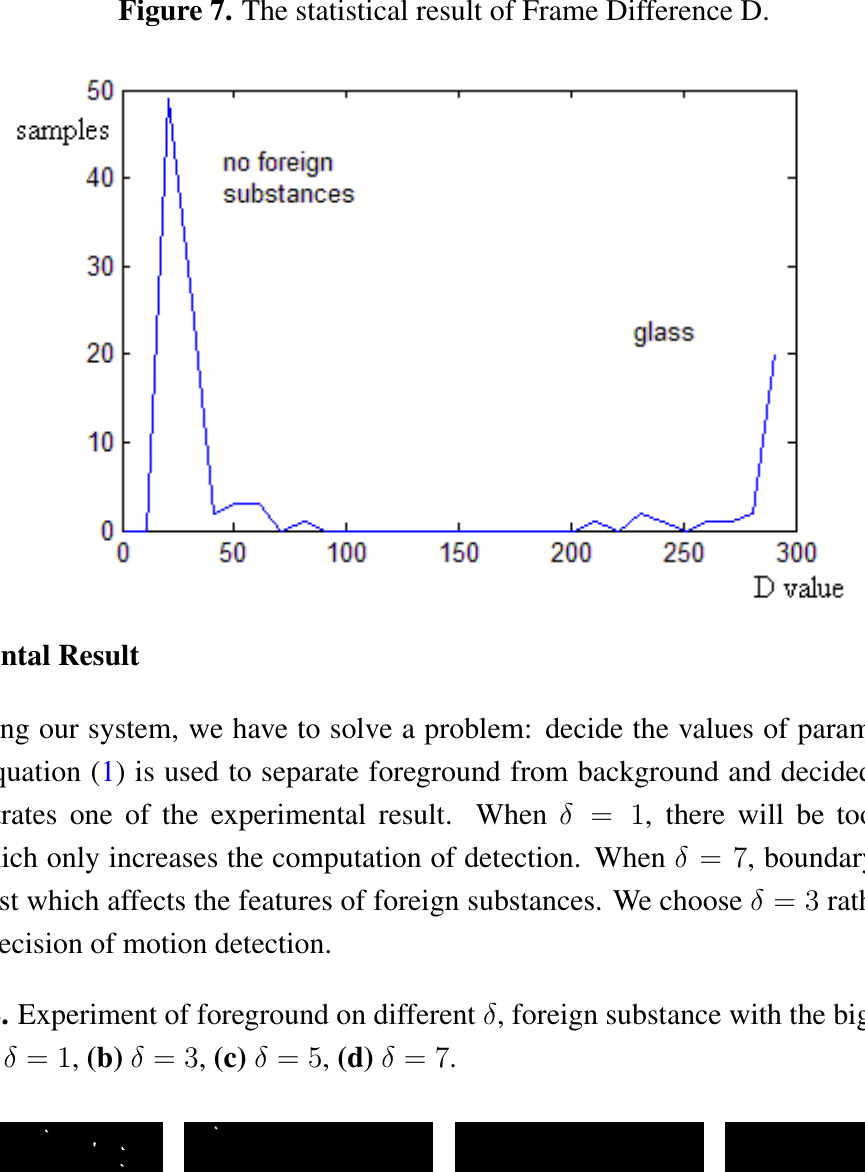
Figure 7. The statistical result of Frame Difference D.